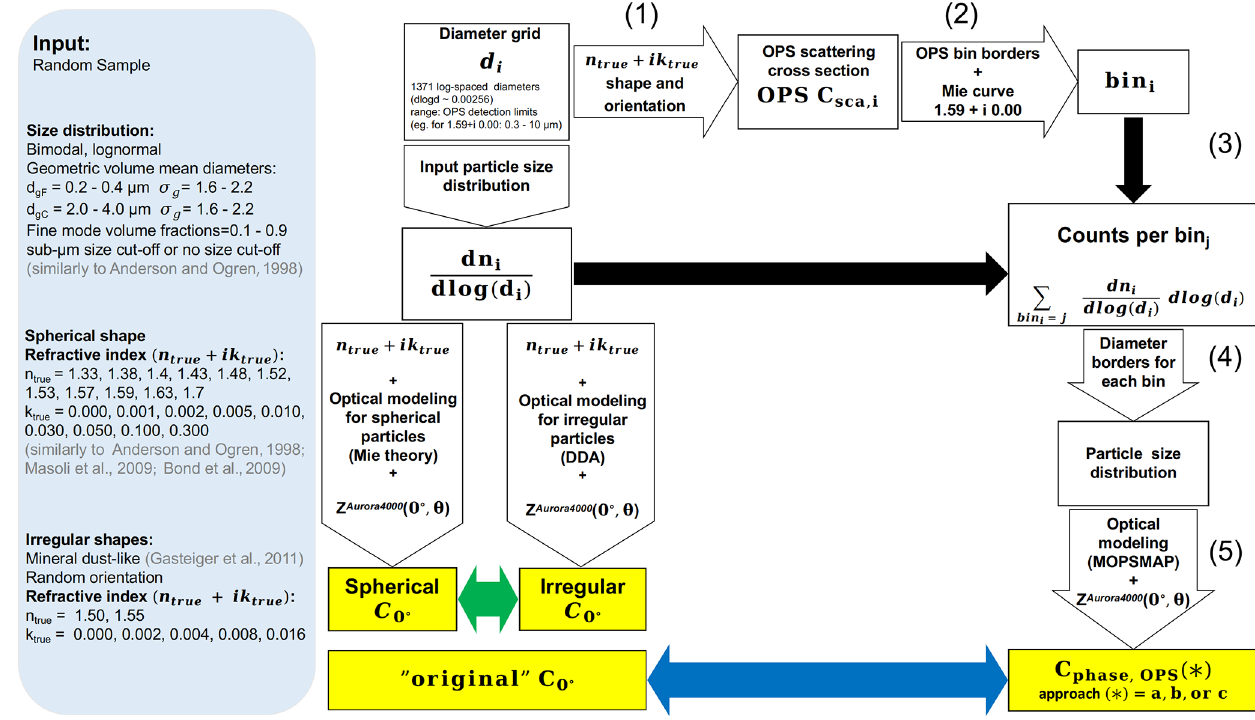
Figure 4. Flow chart for the simulated closure experiment. The input parameters are selected randomly among the values indicated in the left box. The “original” angular correction C 0 ◦ is calculated directly on a given diameter grid for the input size distributions and refractive indices (left side of the flow chart), for homogeneous spherical particles with Mie calculations (spherical C 0 ◦ ), and for irregular particles with discrete dipole approximation (irregular C 0 ◦ ). To simulate the angular correction C phase , OPS corresponding to each original C 0 ◦ considered, the steps 1–5 are performed. Different approaches to run the five steps are